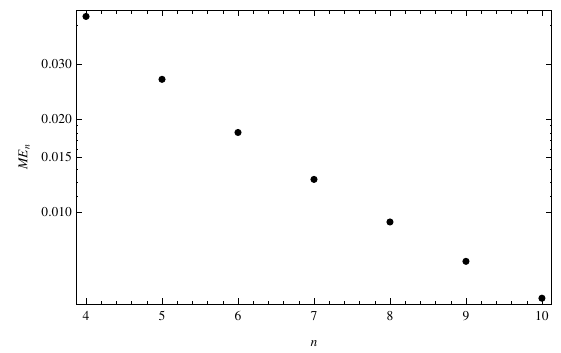
Figure 6: Logarithmic plots of the ME n for n = 4 through